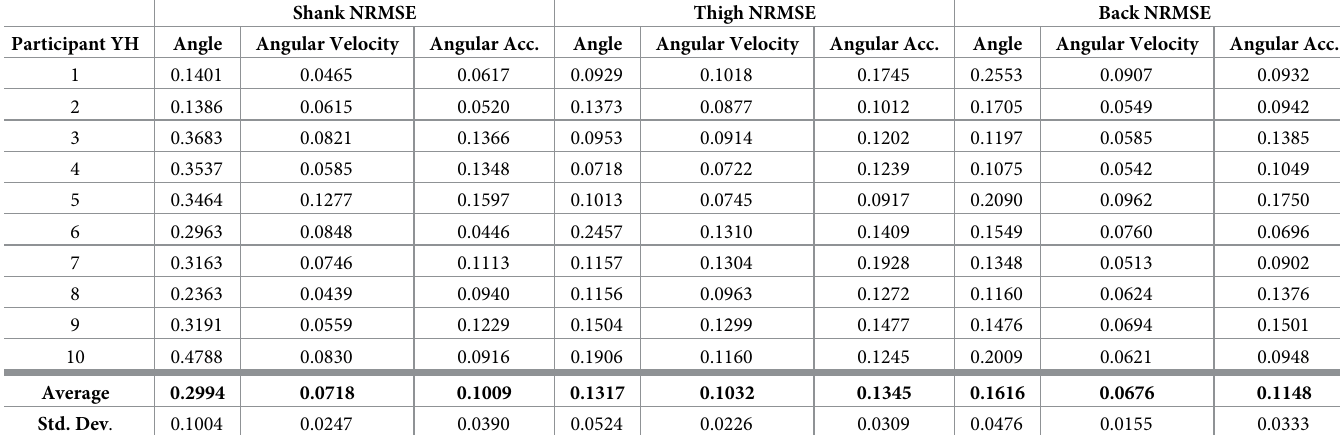
Table 1. Normalised root mean squared error (NRMSE) for shank, back and thigh for all the young healthy (YH) participants. Shank